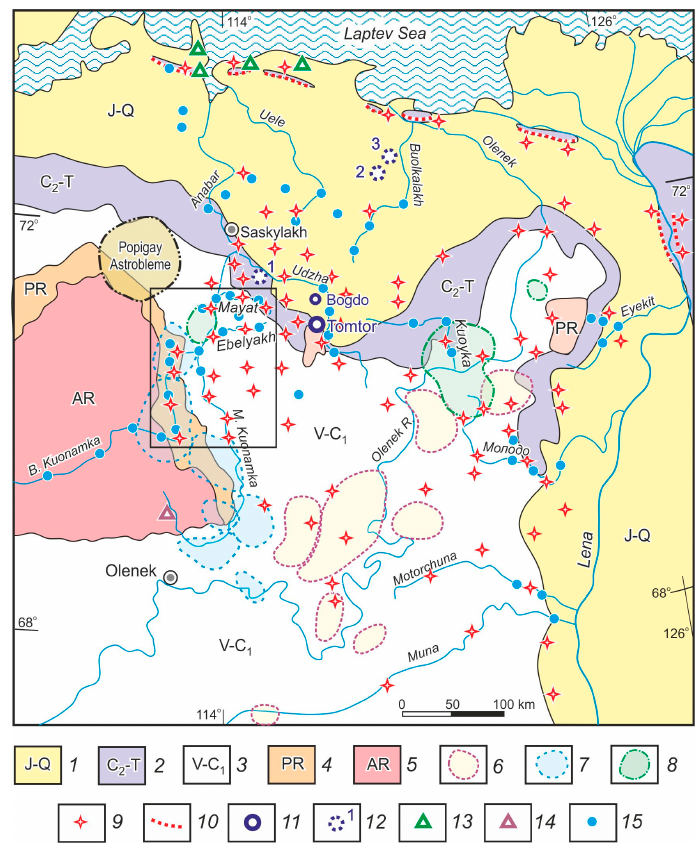
Figure 1. Distribution scheme of diamond, gold, and platinum in placers of the Lena–Anabar province (modified after [11]): 1—Jurassic–Cenozoic sediments; 2—Carboniferous–Triassic sand- stones and siltstones; 3—Vendian–Carboniferous dolomites, limestones and sandstones; 4—Proterozoic rocks; 5—Archean metamorphic complexes; 6–8—Fields of kimberlites and car- bonatites according to [17]: Middle Paleozoic (6), Early Mesozoic (7) and Late Mesozoic (8); 9—diamonds in placers [17]; 10—diamonds in tuffite of the Carnian stage [18]; 11—Tomtor and Bogdo massifs; 12—massifs assumed according to geophysical data [12]; 13—picrite-basalts, mouth of the Anabar river [13,14]; 14—dike of meimechite-like rocks [15]; 15—gold and platinum in placers [3,16]. The rectangle frame is the location of the research area.